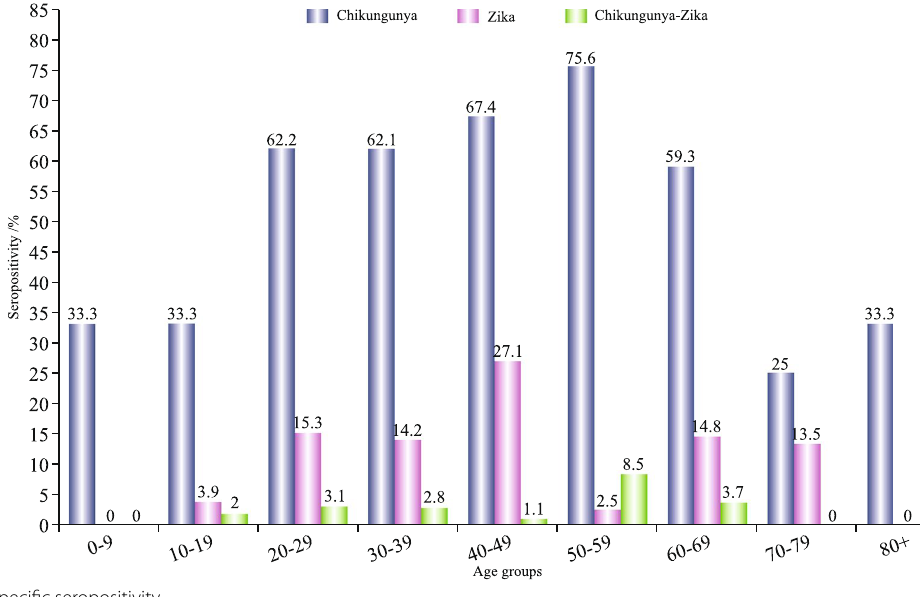
Fig. 3 Age-specific seropositivity